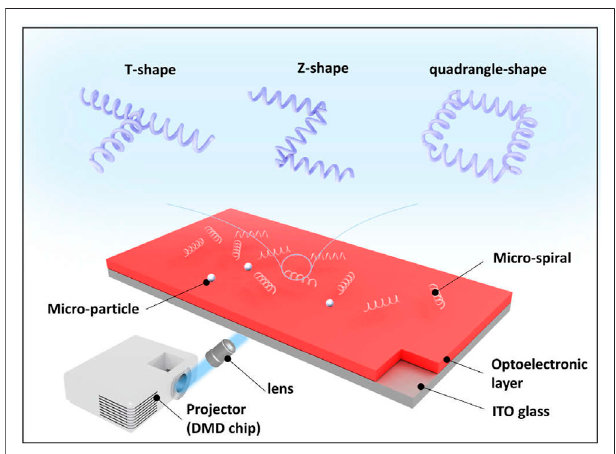
FIGURE1| Conceptualoverviewof fl exibleassemblyofmicro-spirals via